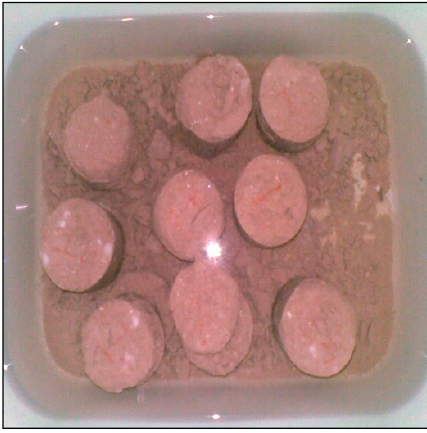
Figure 5. Specimens after the freeze–thaw test.